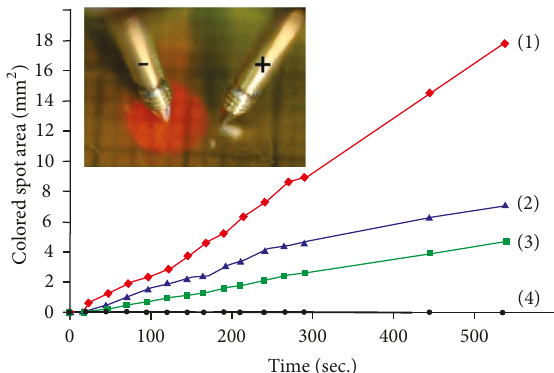
Figure 9: Colored spot area as a function of time of voltage application: (1) the negative electrode is located on nonhydrogenated region and the positive one on hydrogenated region (see insert); (2) both electrodes are on as-prepared (nonhydrogenated) film; (3) both electrodes are on hydrogenated film; (4) the negative electrode is located on hydrogenated region, and the positive one on initial film.